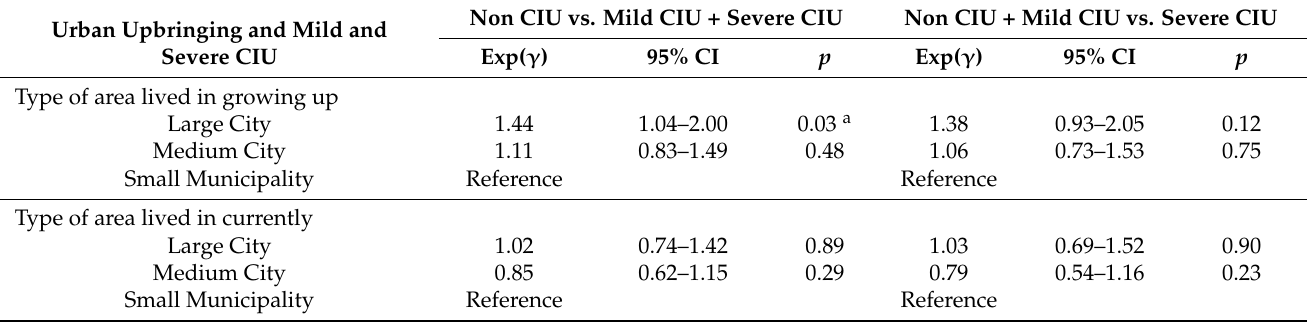
Table 3. Urban upbringing and mild and severe compulsive internet use (CIU) based on the Compulsive Internet Use Scale (CIUS) scores of adult community residents in Japan: generalized linear mixed model (mixed effects logistic regression) analysis (N =